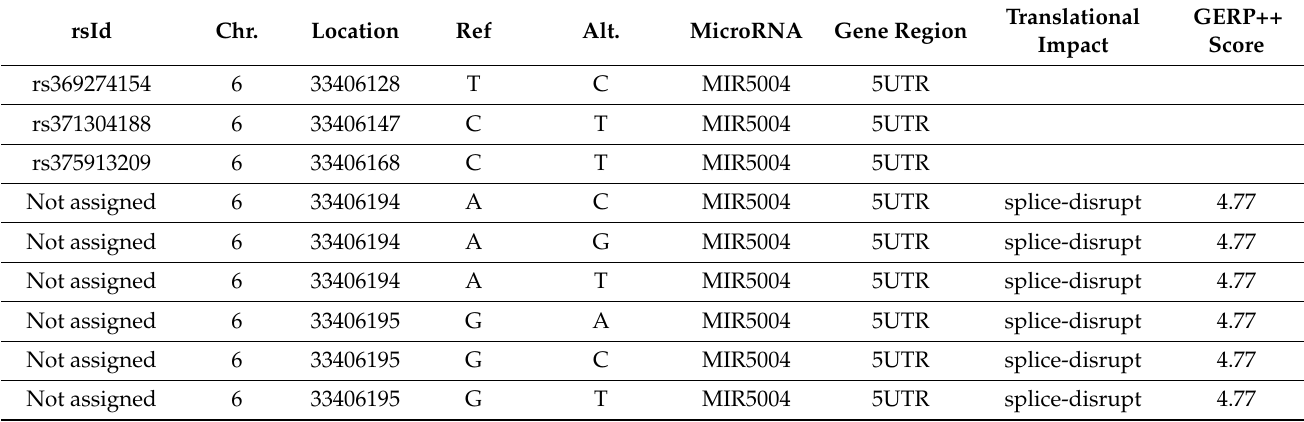
Table 4. hsa-miR-5004-3p genomic variation. High GERP++ conservation score is associated with higher functional impact. rsId Chr.